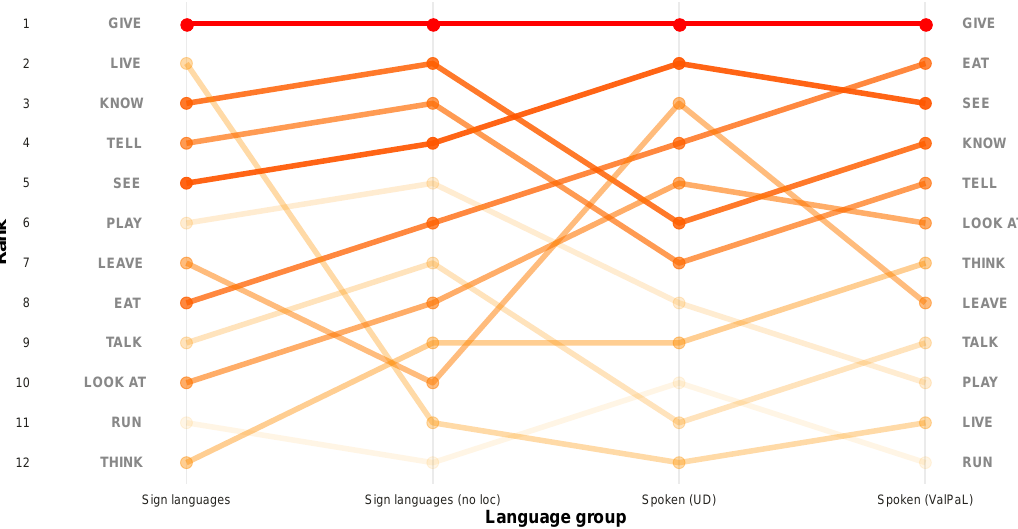
Figure 6: The rank of the 12 ValPaL meanings in terms of their averaged transitivity prominence across the five sign languages, the six spoken UD languages, and the ValPaL data from Haspelmath (2015). Locative arguments are both included and excluded for the sign languages (listed in separate columns). Color indicates the average rank across the three language groups (dark red means higher transitivity-prominence